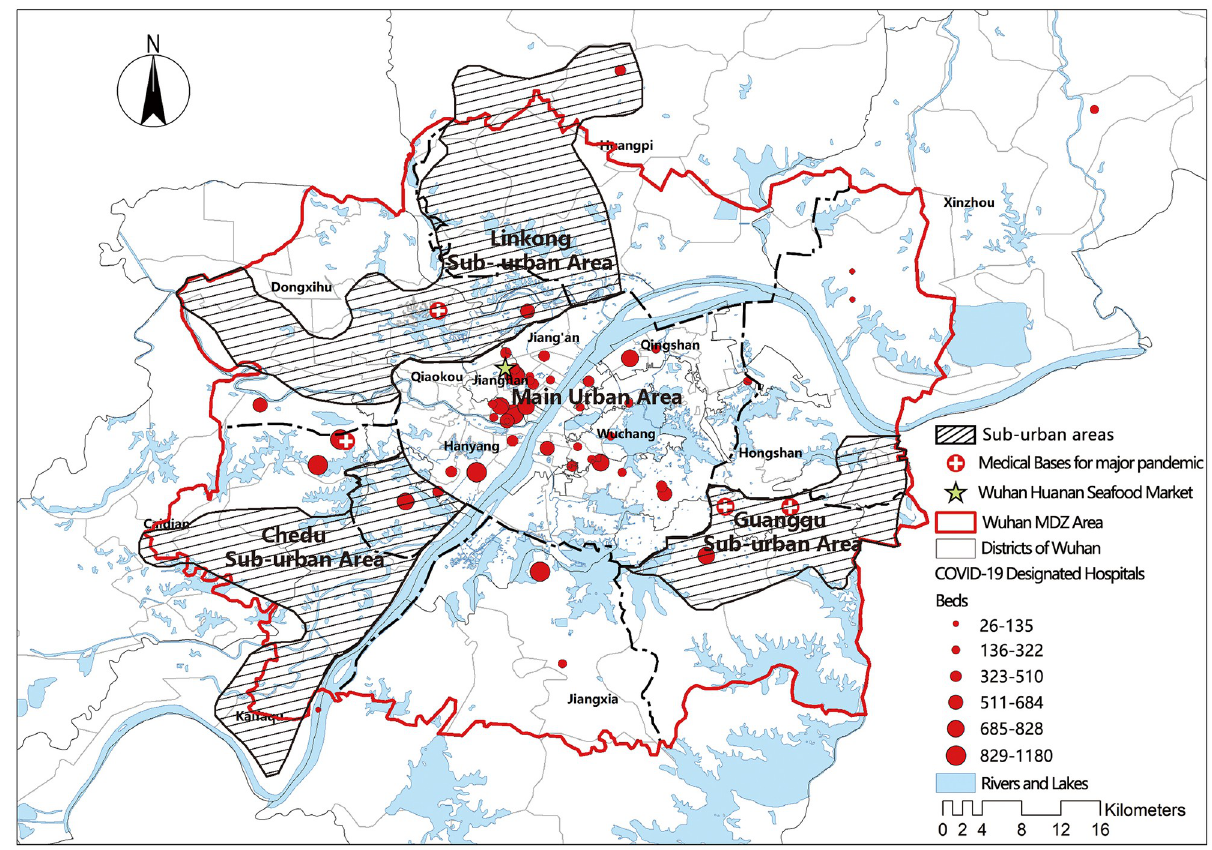
Fig 12. Distribution of sub-urban areas and existing designated hospitals in